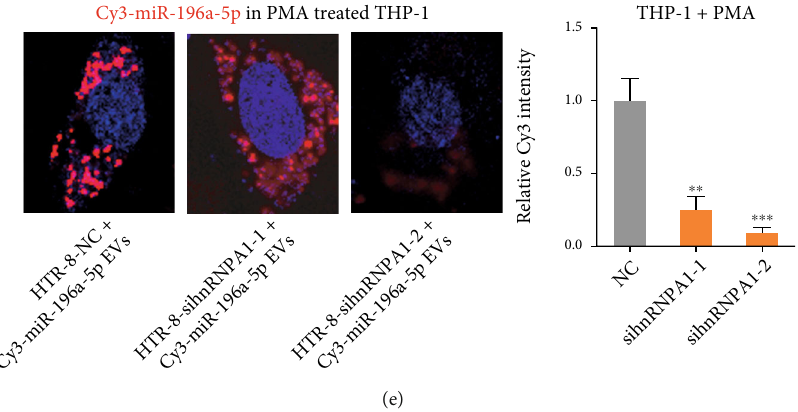
Figure 4: hnRNPA1 regulates miR-196a-5p packaging into EVs from trophoblasts. (a) The mRNA and protein expression levels of hnRNPA1 were evaluated by qPCR and western blotting in HTR-8 cells transfected with si-hnRNPA1 as well as the control siRNA. (b) qPCR analysis of miR-196a-5p expression levels in HTR-8 cell-derived EVs and the HTR-8 cells after transfection with si-hnRNPA1. (c) miRNA pull-down assays were performed using the nuclear, cytoplasmic, or EV lysates of HTR-8 cells. The expression of hnRNPA1 pulled by biotin- labeled miR-196a or mutant miR-196a was analyzed using western blotting. (d) RIP assays with hnRNPA1 antibody or IgG were performed using the lysates of HTR-8 cells or the EVs. (e) Cy3-miR-196a-5p and si-hnRNPA1 were cotransfected into HTR-8 cells for 48h. Then, EVs were isolated and added to the PMA-pretreated THP-1 cells. Fluorescence microscopy was used to evaluate the red fl uorescent signals in THP-1 cells ( ∗ p < 0 : 05 ; ∗∗ p < 0 : 01 ; ∗∗∗ p < 0 : 001 ; ns: not signi fi cant). EV: extracellular vesicle; RIP: RNA